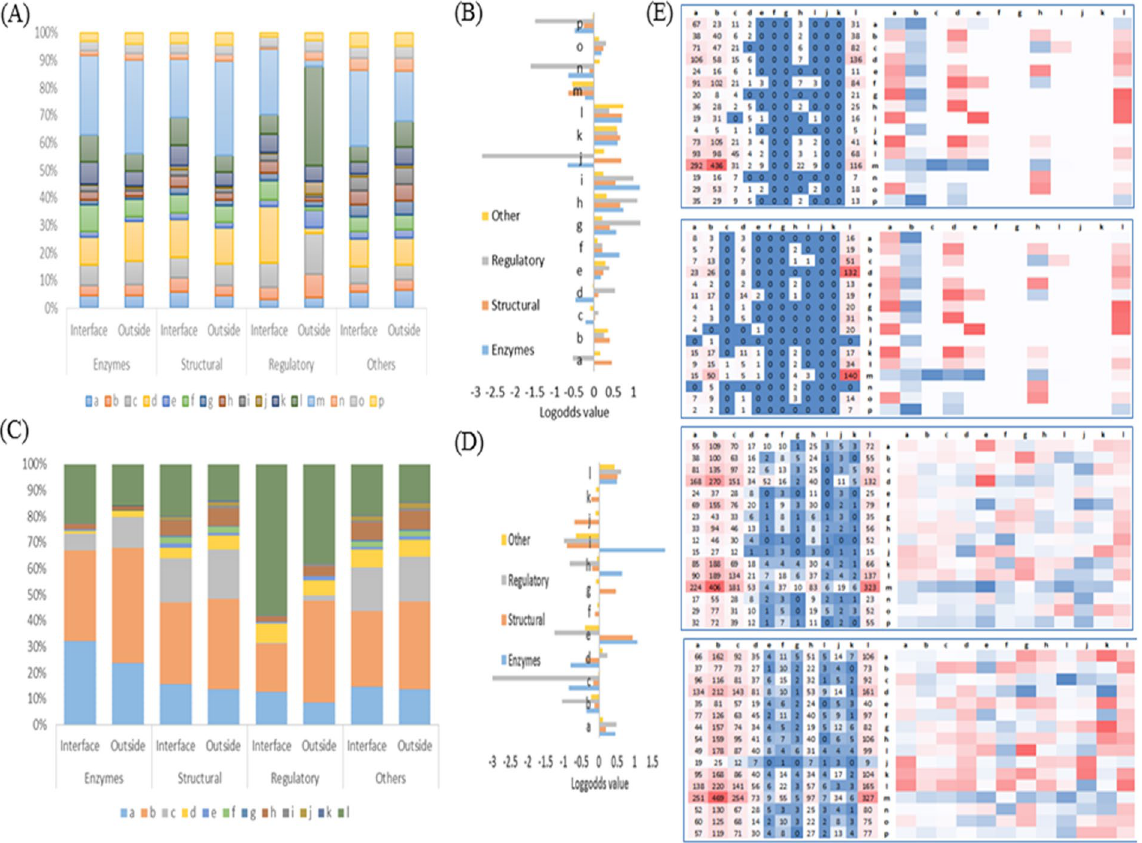
Figure 2. Statistical analysis of protein local conformations (PLCs) and RNA local conformations (RLCs) at and outside the interface for the four types of protein functional classes. ( A ) and ( C ) show the composition percentages of PLCs and RLCs at and outside the interfaces. The corresponding log-adds ratio to represent over and less at and outside the interfaces for PLCs and RLCs are given in ( B ) and ( D ). The mutual interaction propensity matrices between PLCs and RLCs are shown in ( E ). The left side values in ( E ) represent the total number of contacts between PLCs and RLCs and right side boxes represent their corresponding log- odds values. The four classes are shown from top to bottom, are enzymes, structural, regulatory and ‘other’,